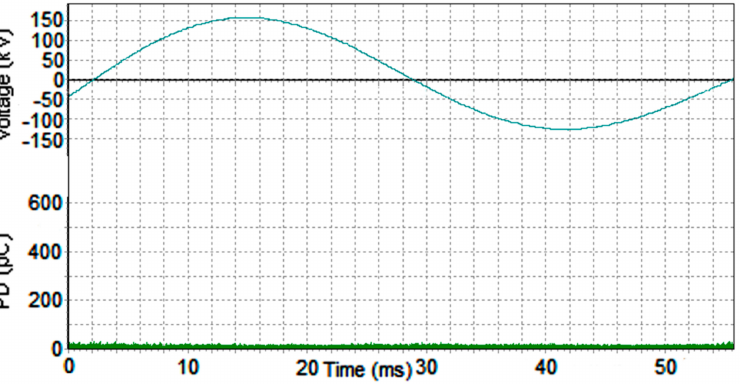
Figure 8. DAC phase-resolved PD pattern only showing the background-noise